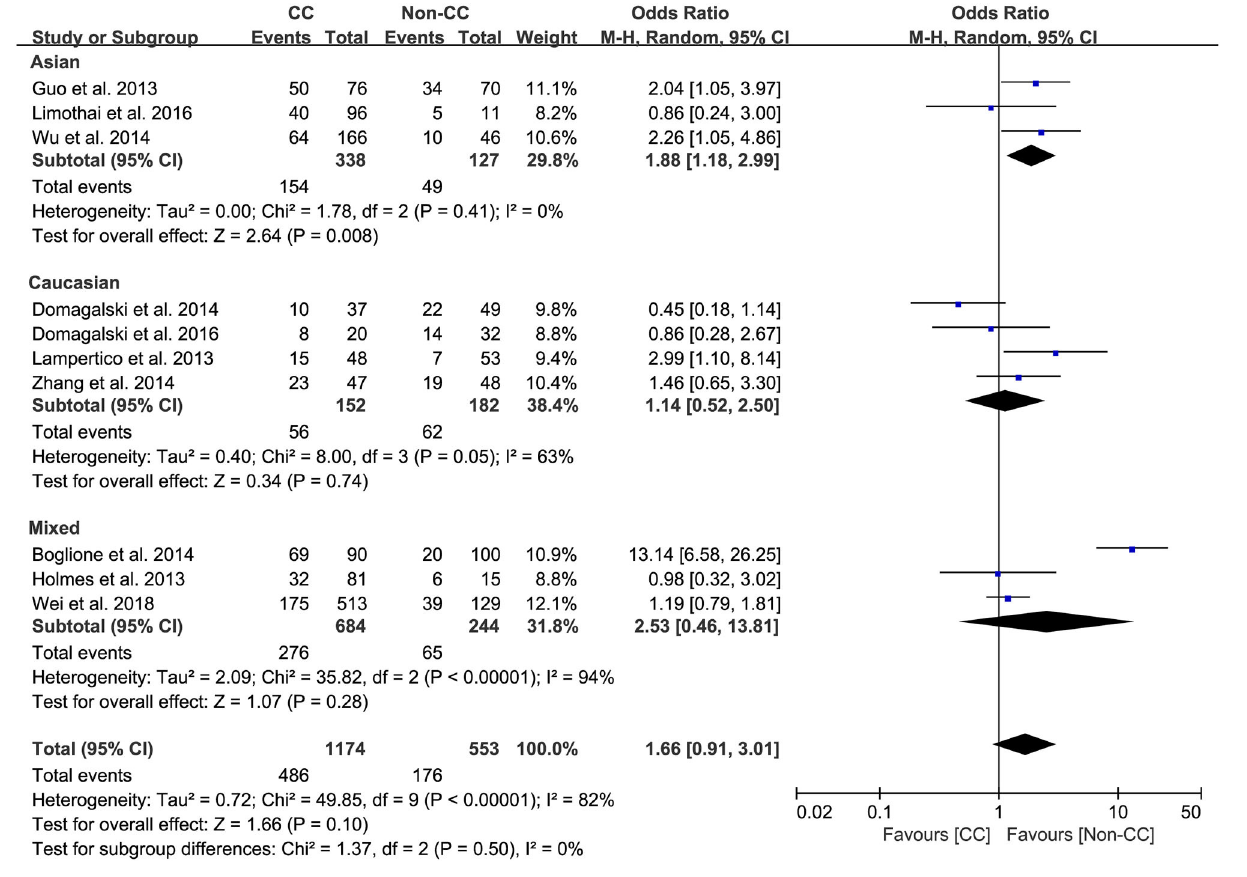
FIGURE 6 | Subgroup analysis of rs12979860, stratified by